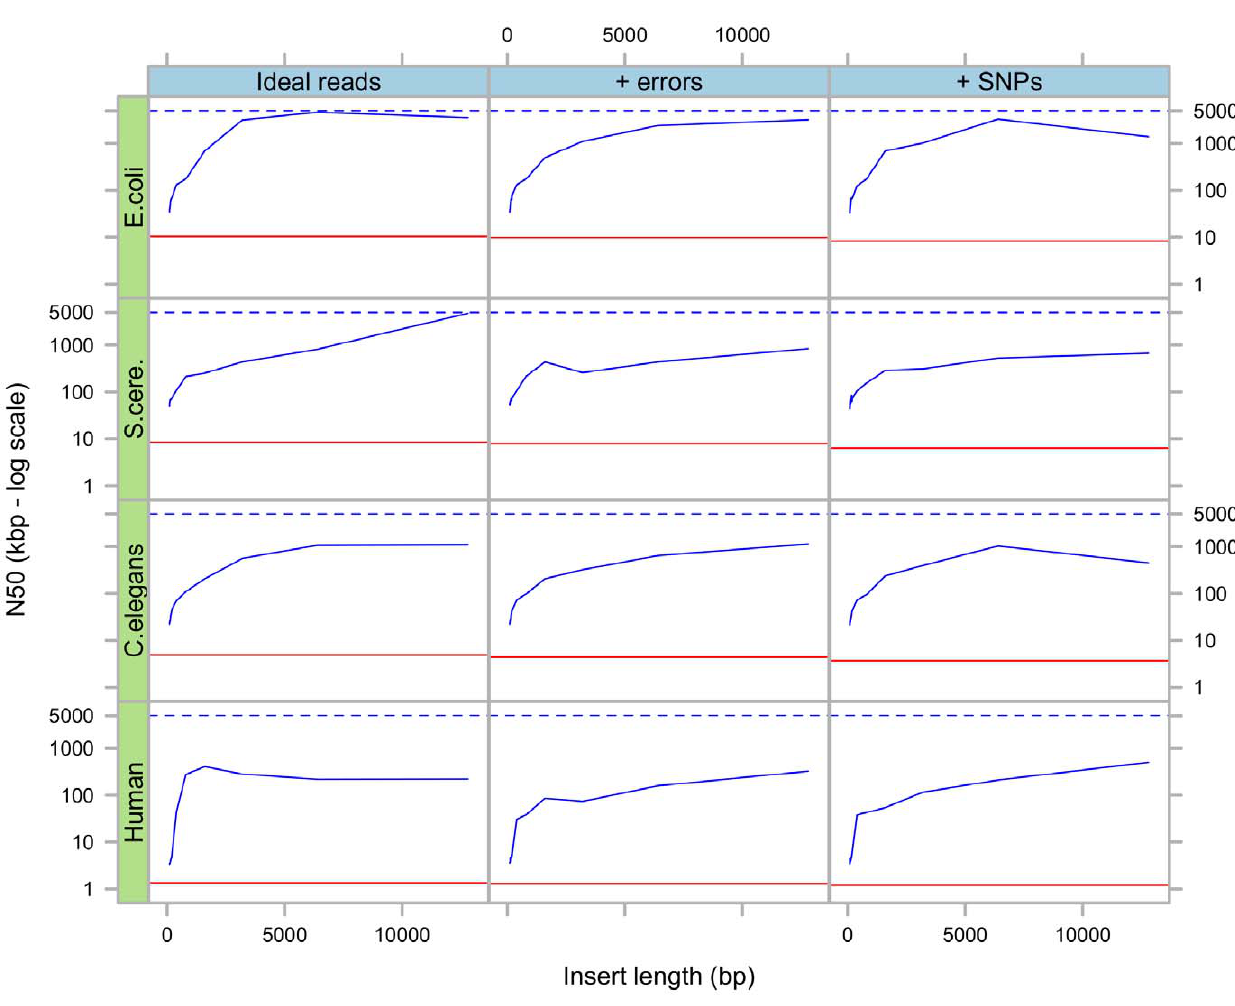
Figure 3. Results of simulations using various insert lengths. Final scaffold N50 as a function of insert length, in four different species and three different simulations scenarios. The horizontal red lines represent the initial N50 after error removal and before repeat resolution. The dashed blue lines represent the highest possible N50, namely the length of the sequence being sampled.